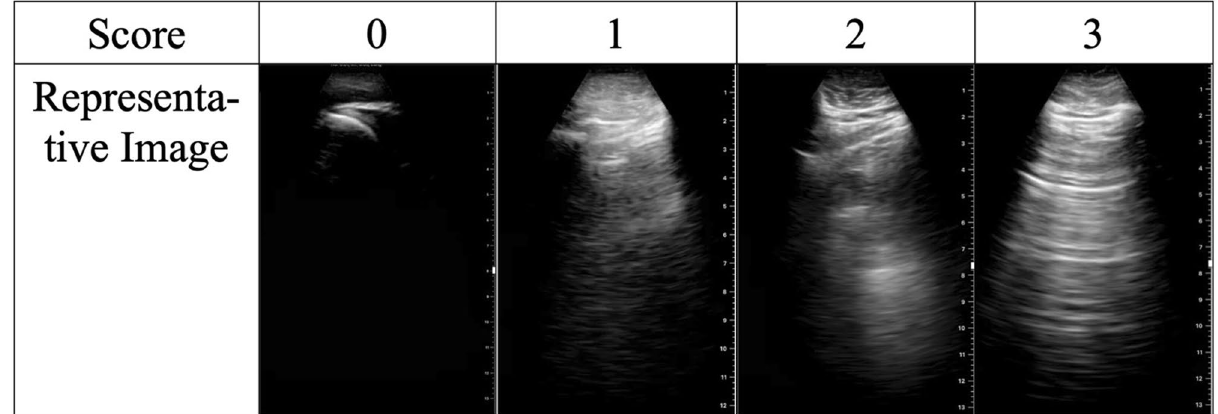
Figure 2. Scoring system used for grading novice- and expert-performed lung